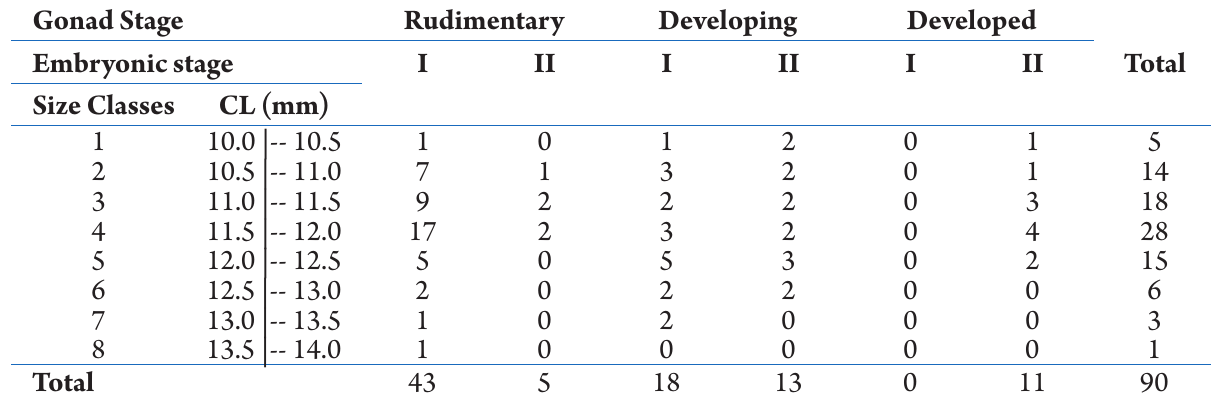
Table 1. Nematopalaemon schmitti (Holthuis, 1950). Number of ovigerous females by size class, gonadal development stage (Rudimentary, Developing, Developed), and embryo development stage (I) and (II). CL = carapace length (mm); I = initial embryonic development; II = final embryonic